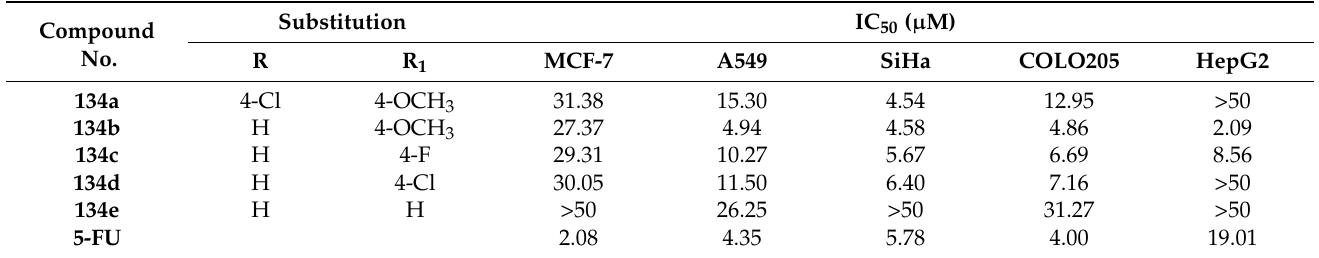
Figure 123. Structure of pyrazoline ‐ pyrazole ‐ based derivatives 134 ( a – e ). Table 110. In vitro cytotoxic activities of pyrazoline-pyrazole-based hybrid compounds 134 ( a – e ). Table 110. In vitro cytotoxic activities of pyrazoline ‐ pyrazole ‐ based hybrid compounds 134 ( a – e ).